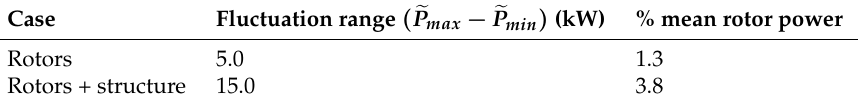
Table 5. High frequency power fluctuation ranges for rotor and rotor + structure